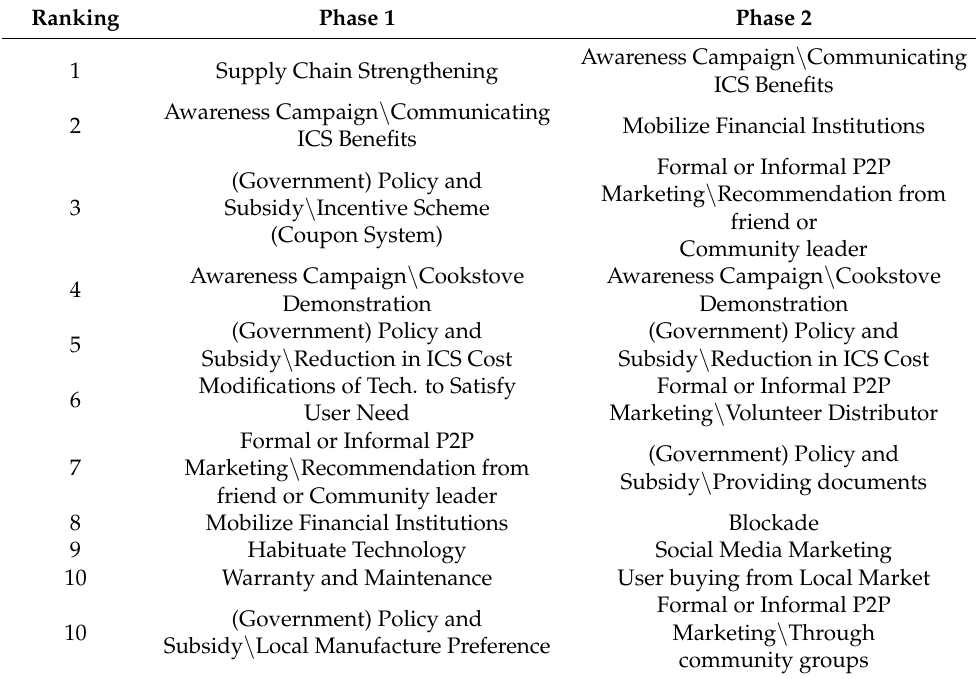
Table 4. Top 10 Engagement